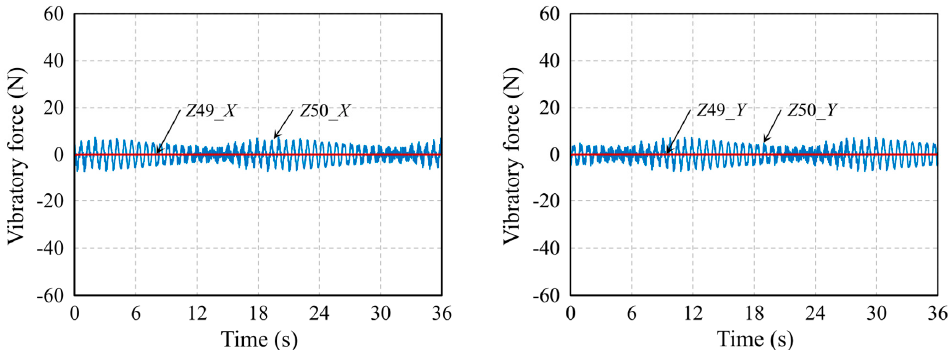
Figure 6. Vibratory forces at the center of the reducer at 10 deg/s (_ X : x-axis direction, _ Y : y-axis direction).